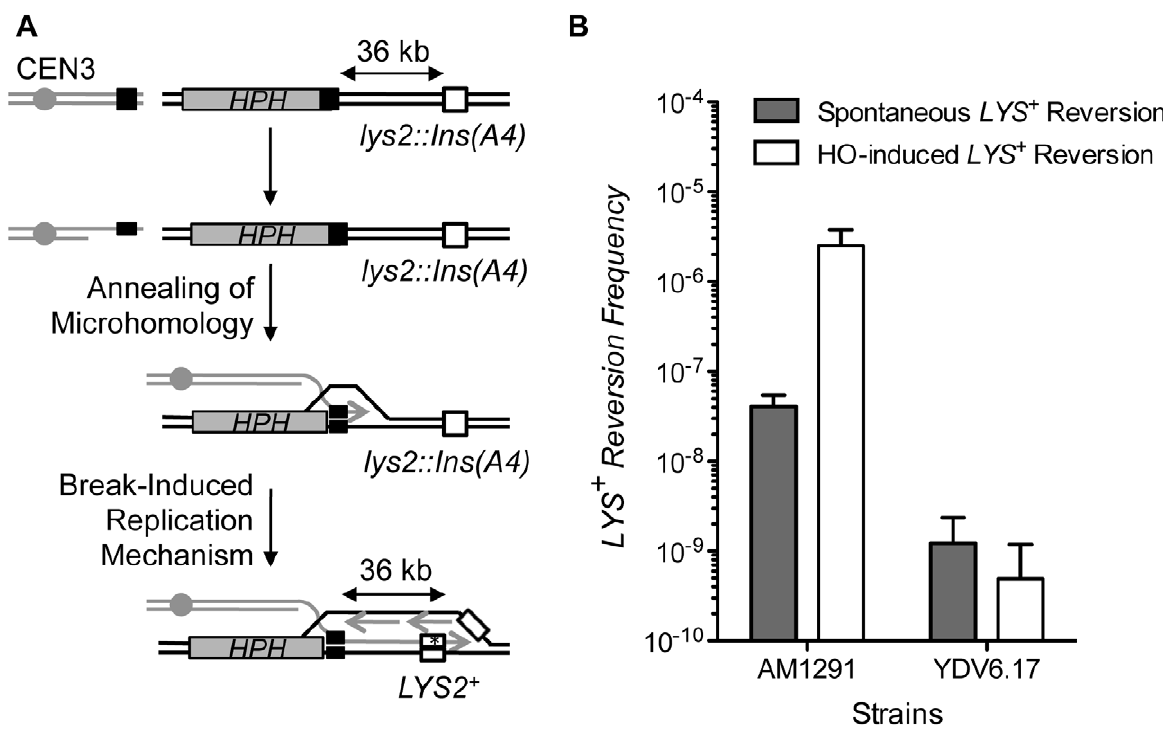
Figure 4. MHMR does not depend on long-range repair synthesis. (A) A diagram illustrating how microhomology repairs the break using a BIR mechanism. BIR has been shown to increase mutational frequency of lys2::Ins(A4) to LYS2 + by frameshift mutation, which is shown as a white box [52]. The position of the centromere (gray circle), HPH (gray boxes) and the microhomology (black boxes) are shown. (B) Spontaneous and HO- induced LYS + reversion frequency was calculated using the average median value of five strains in three independent experiments in AM1291 that uses BIR to repair a DSB and YDV6.17 that carries 17 bp of microhomology. The results are the average of the median values 6 S.D. (2 kb long) telomeric 3 9 flap but lacks a 2 bp 3 9 flap on the